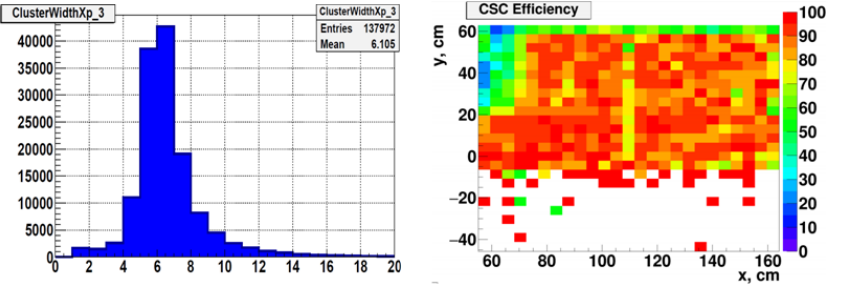
Figure 4. Cluster width for the CSC (left). E ffi ciency distribution (right)